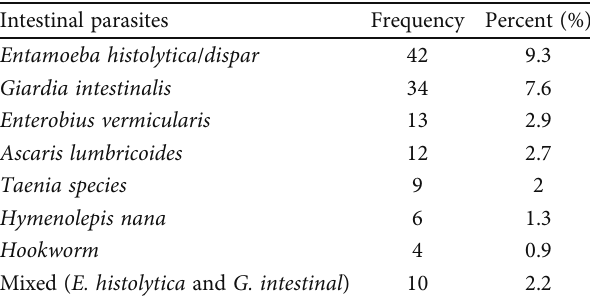
Table 4: Prevalence of identi fi ed parasite species among school children in Dessie town, North-central Ethiopia,